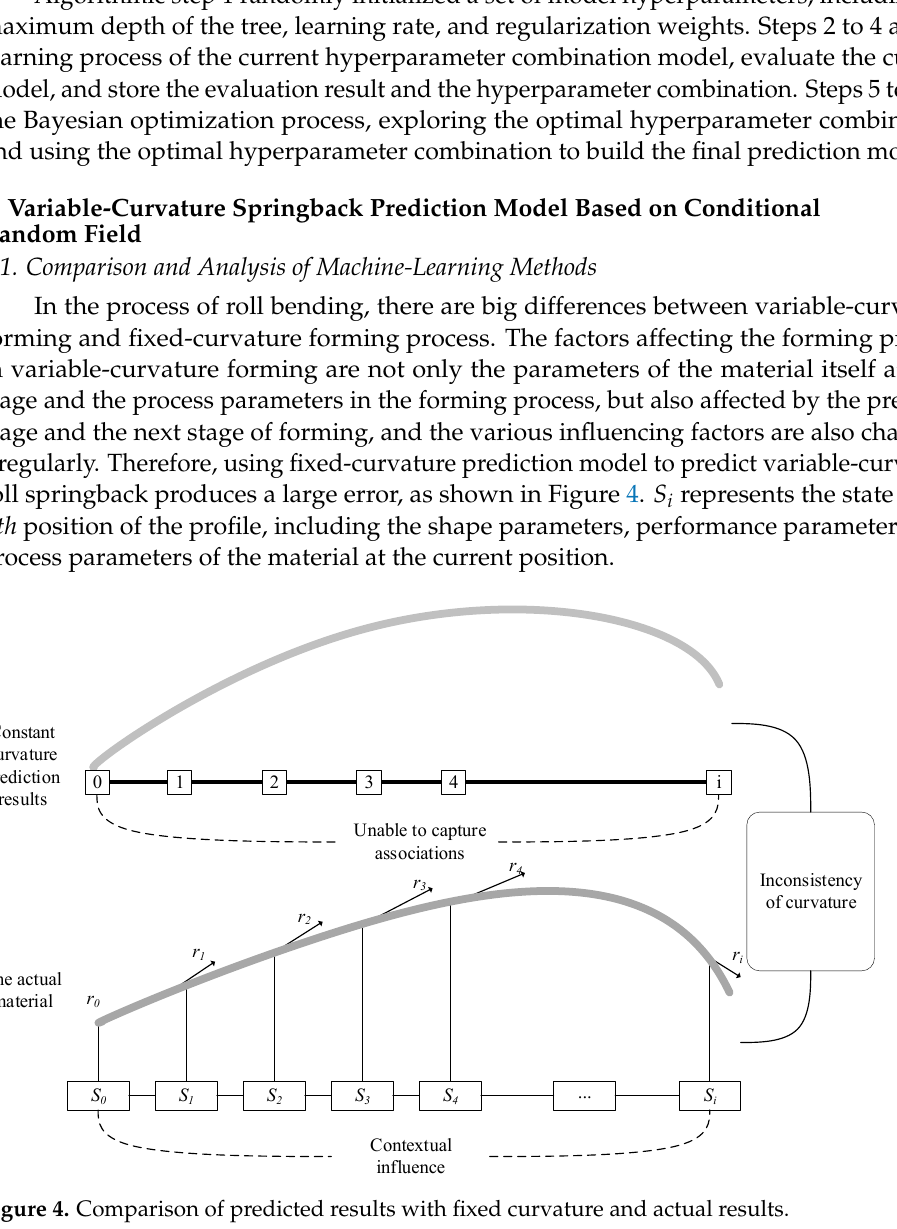
Figure 4. Comparison of predicted results with fixed curvature and actual